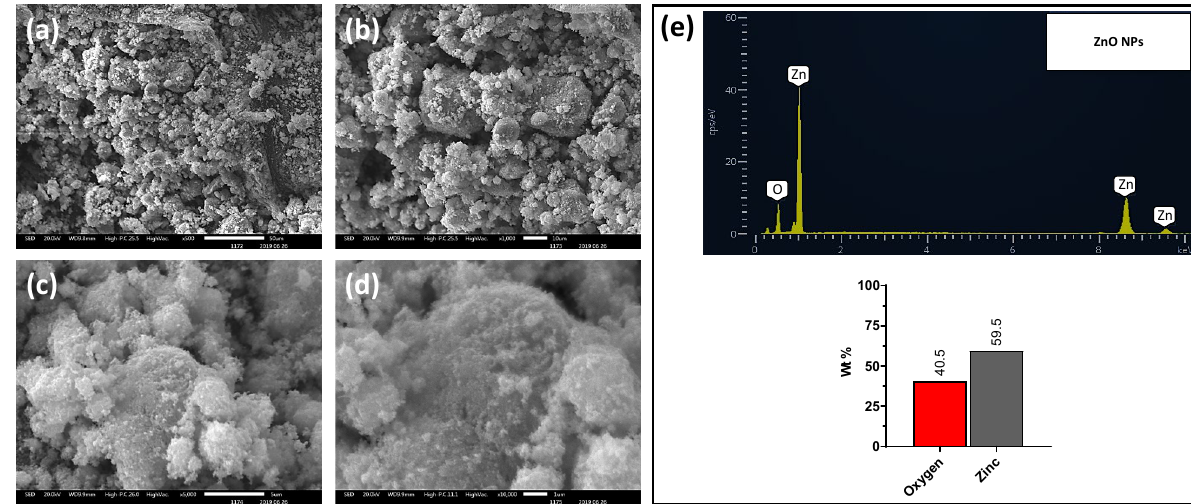
Figure 7. ( a – d ) Scanning electron micrographs before adsorption of Cu(II) ions (pH = 7.0) ( e ) SEM-EDX spectra and elemental mapping (atomic percentage %) of ZnO NPs before adsorption of Cu(II) ions. The magnifications shown in SEM images were 500× ( a ), 2000× ( b ), 4000× ( c ) and 5000× ( d ).